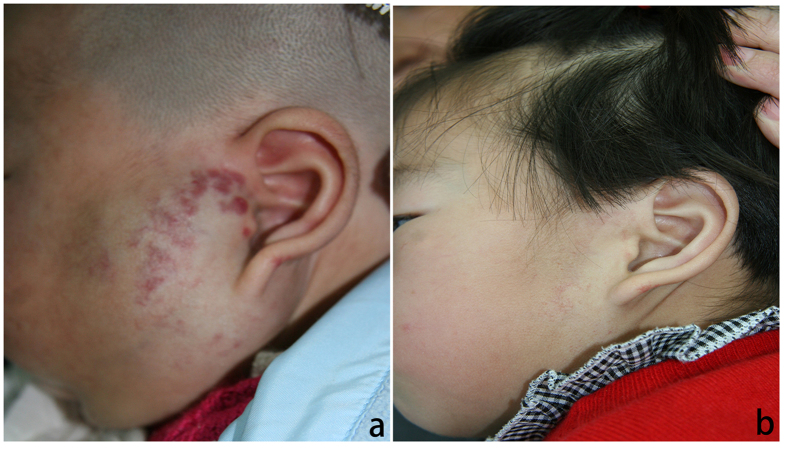
(a) A 3-month-old male patient with a large hemangioma located over the left parotid gland. (b) The same patient at 10 months following treatment with oral propranolol. Note that the hemangioma is almost completely resolved.